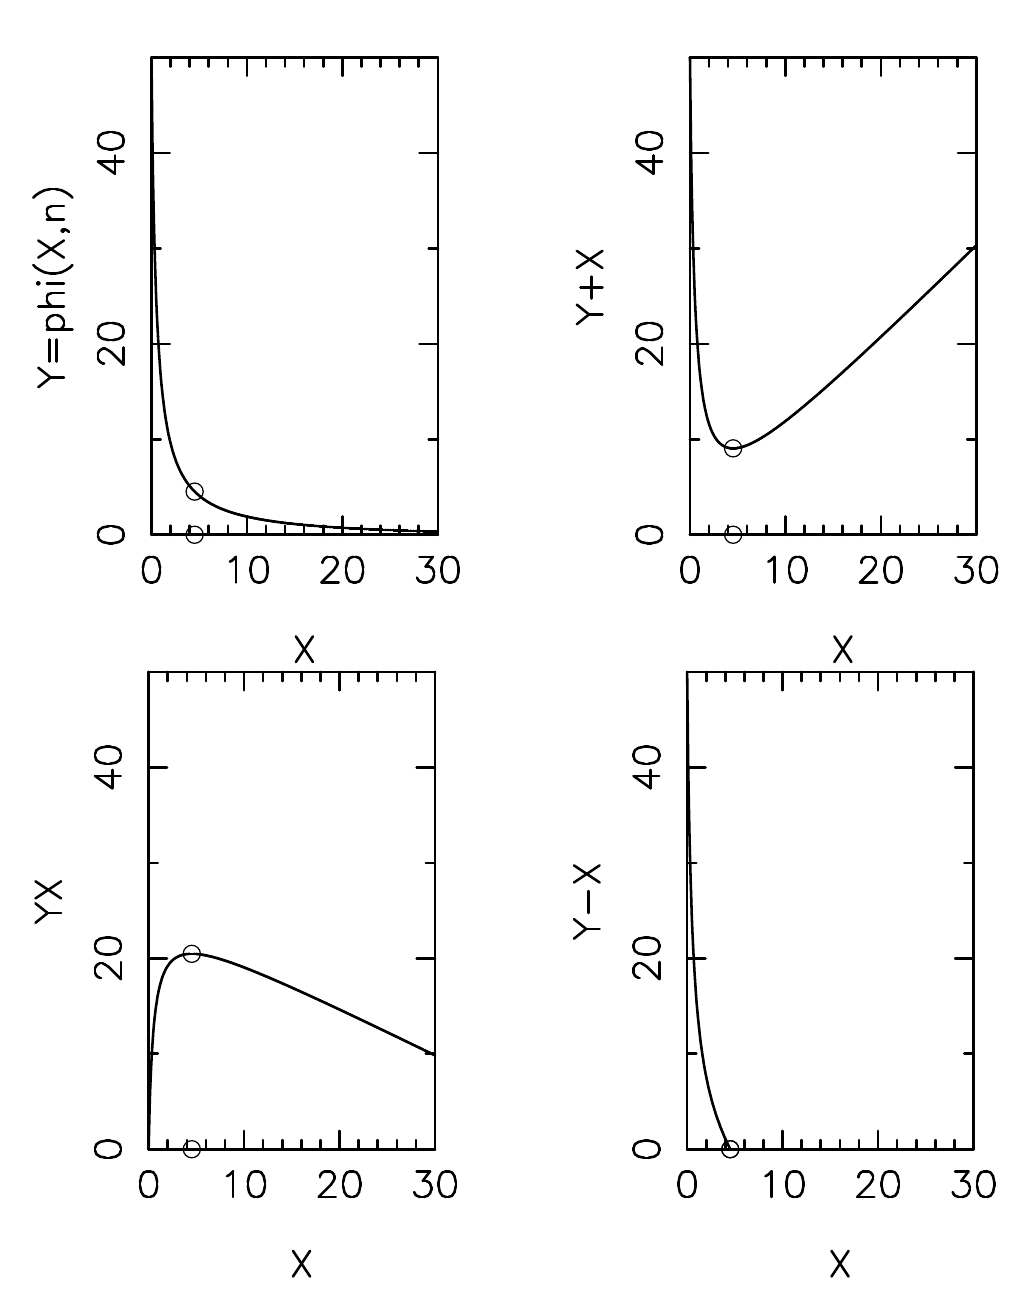
( x ) , top right x + y , bottom left xy , bottom right Figure 1: Top left y = φ n y − x . Circle: point x = I on the x axis, and corresponding points on the curves. n n = 50 , I = 4 . 52 n